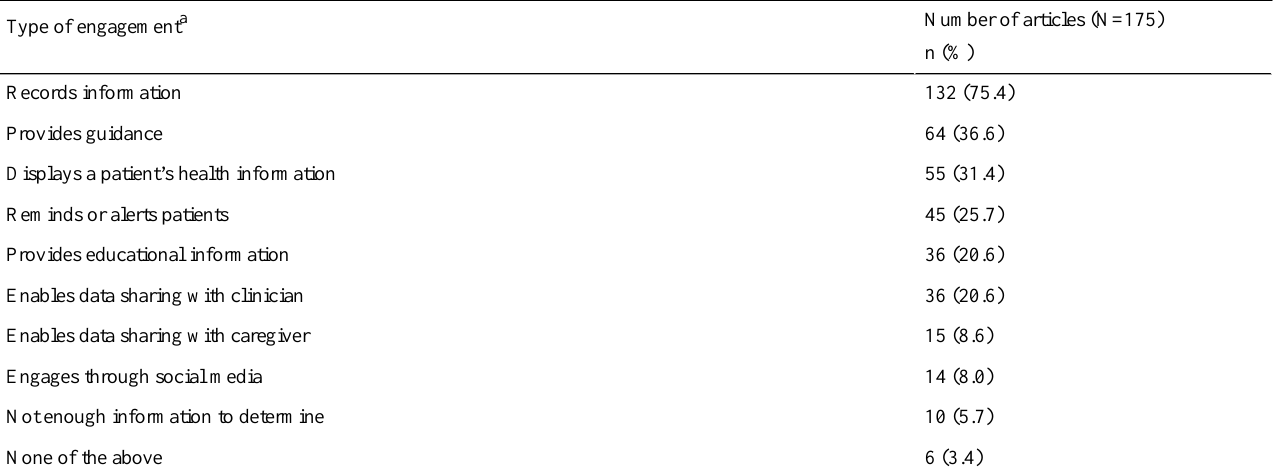
Table 3. How health apps engage patients.